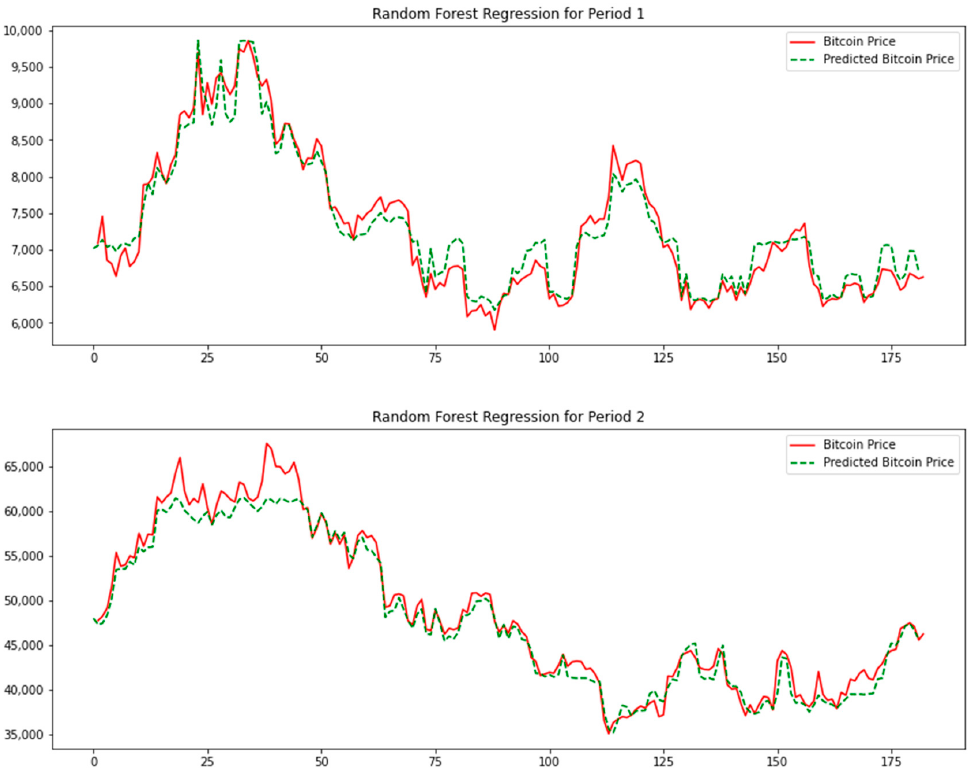
Figure 8. Predicted price based on random forest regression and actual price comparison.